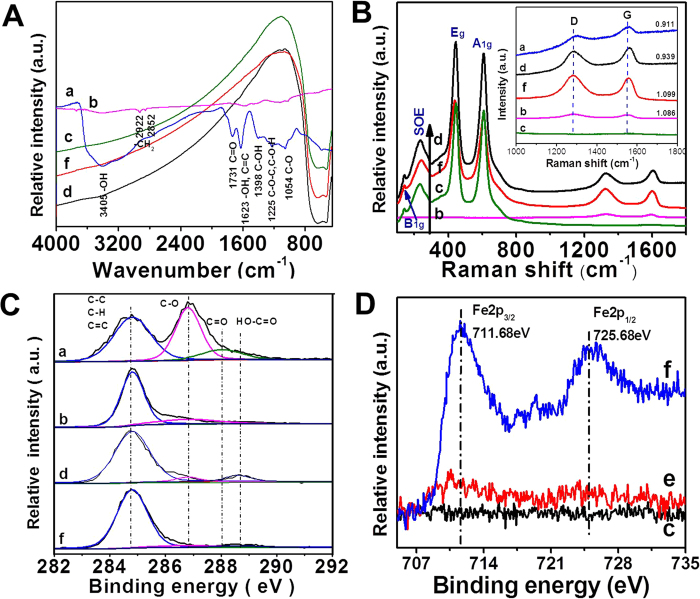
(A) FTIR spectra, (B) Raman spectra, (C,D) XPS spectra of C 1 s (C) and Fe 2p (D) of various samples: (a) GO; (b) rGO; (c) TiO2; (d) rGO-TiO2; (e) Fe(III)/TiO2; (f) Fe(III)/rGO-TiO2.